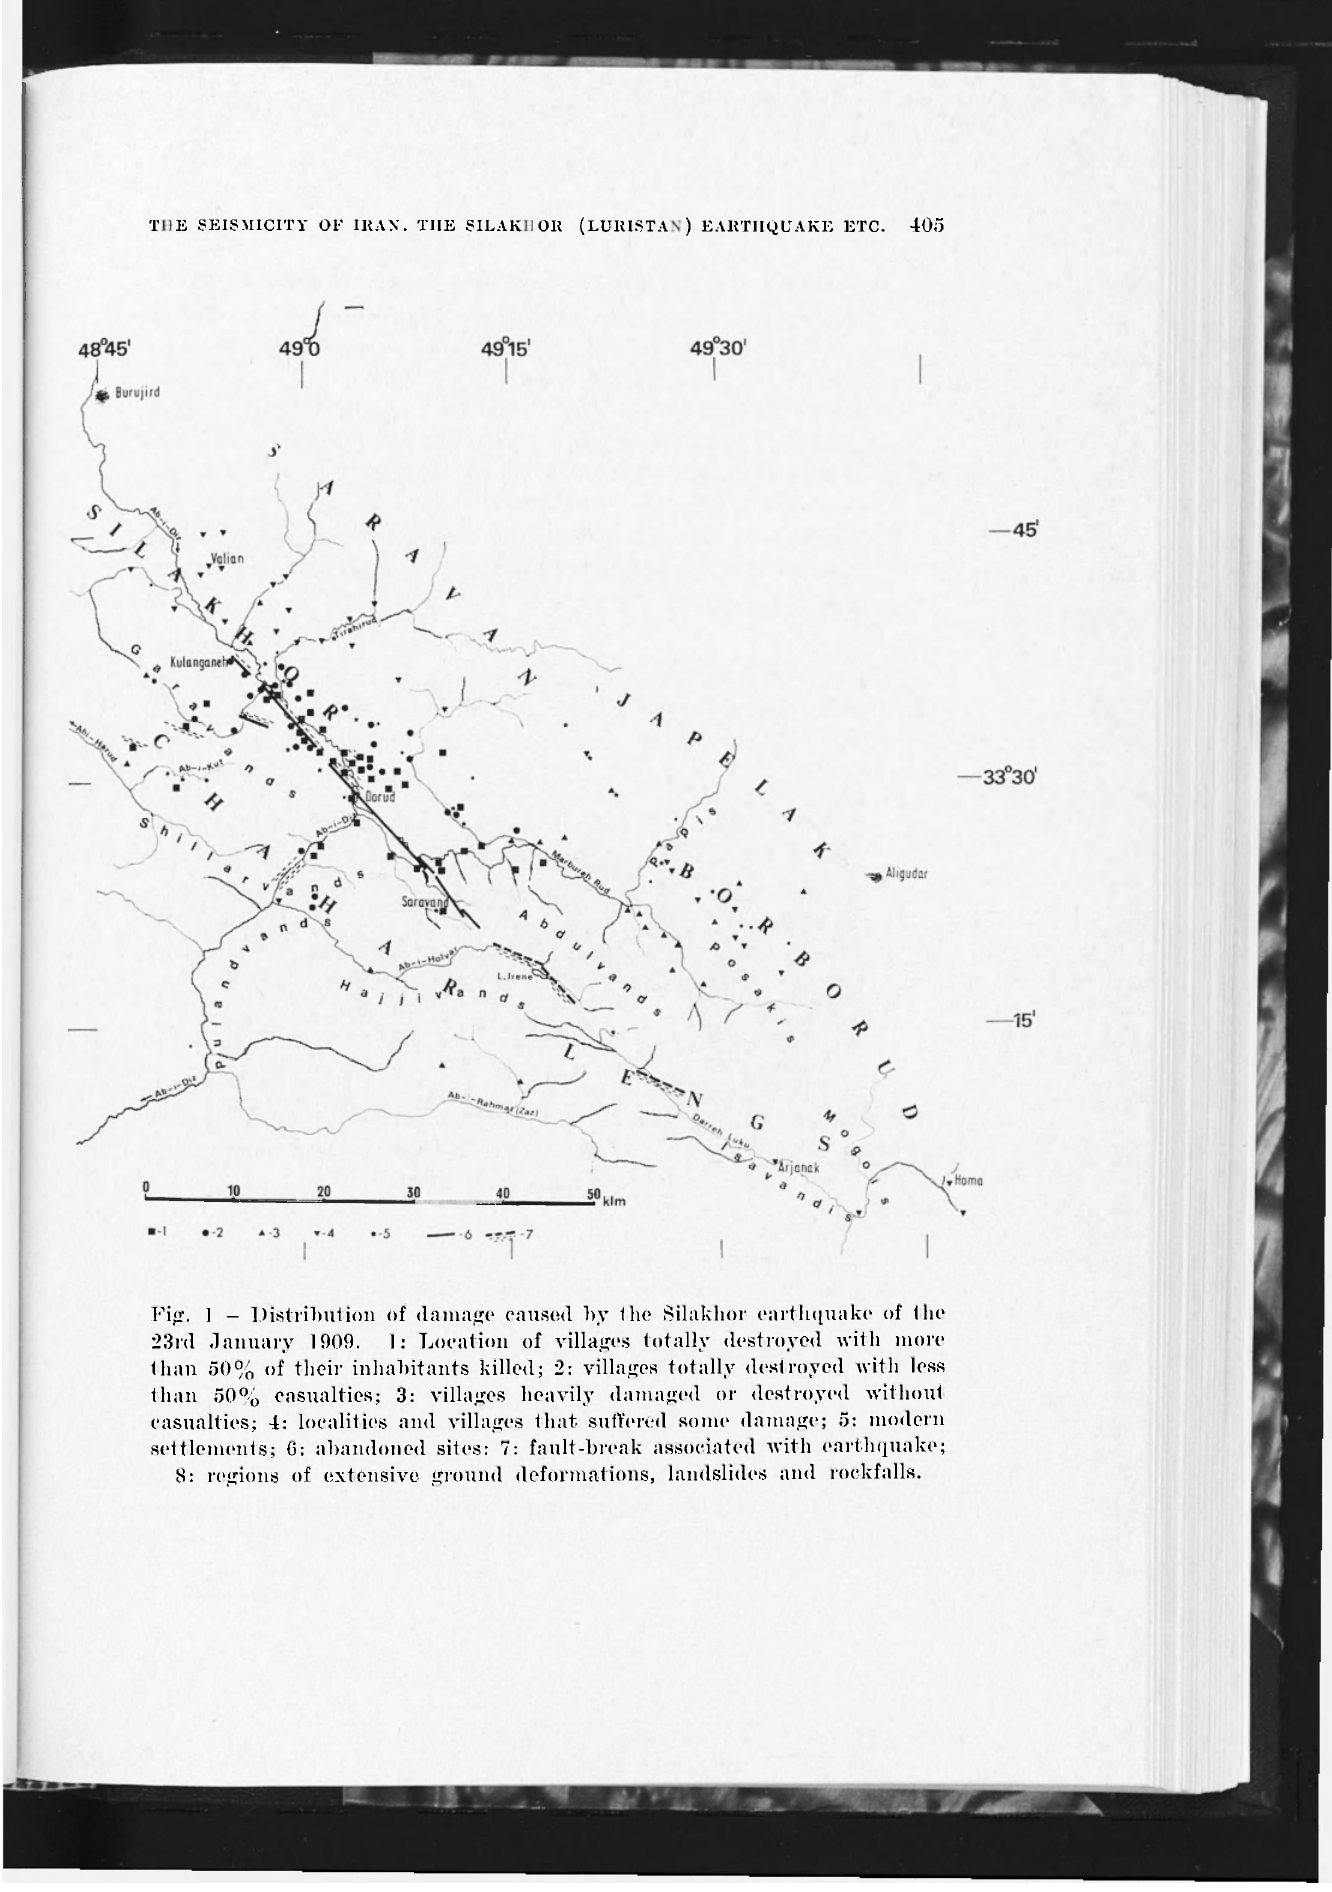
Fig. 1 - Distribution of damage caused by the Silakhor earthquake of the 23rd January